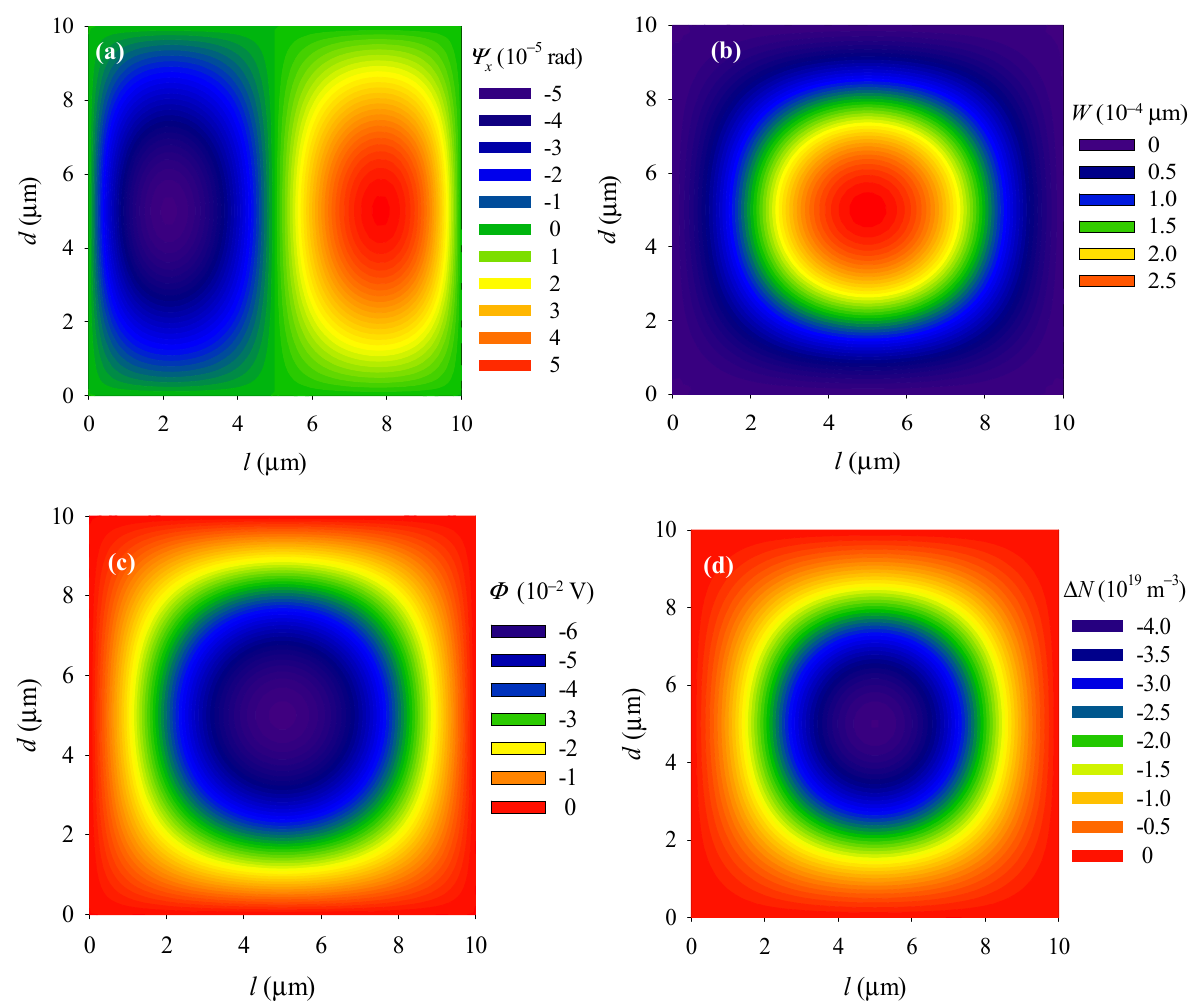
Figure 3. Distributions of ( a ) shear displacement Ψ x , ( b ) deflection W , ( c ) electric potential Φ , and ( d ) electron concentration perturbation Δ N in the plate.